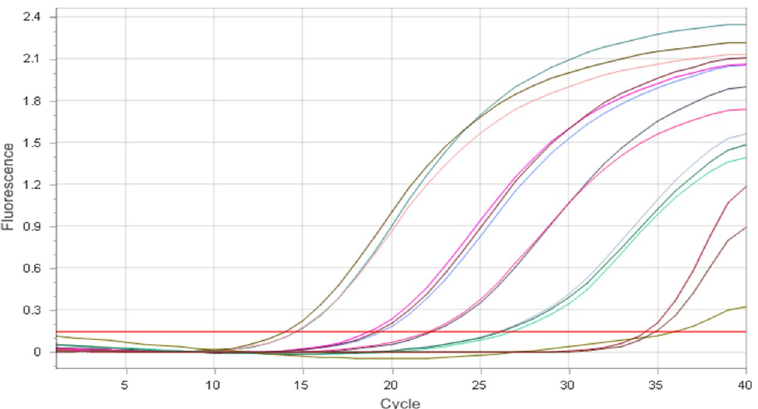
Fig 4. Amplification curves of 10-fold serial dilutions of E . coli DNA.